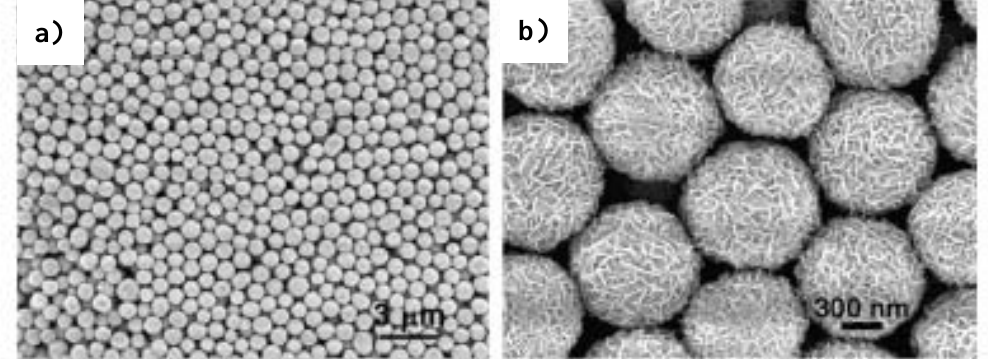
Figure 11. FESEM images of anatase TiO with permission from ref. [72]. Copyright 2010 American Chemical